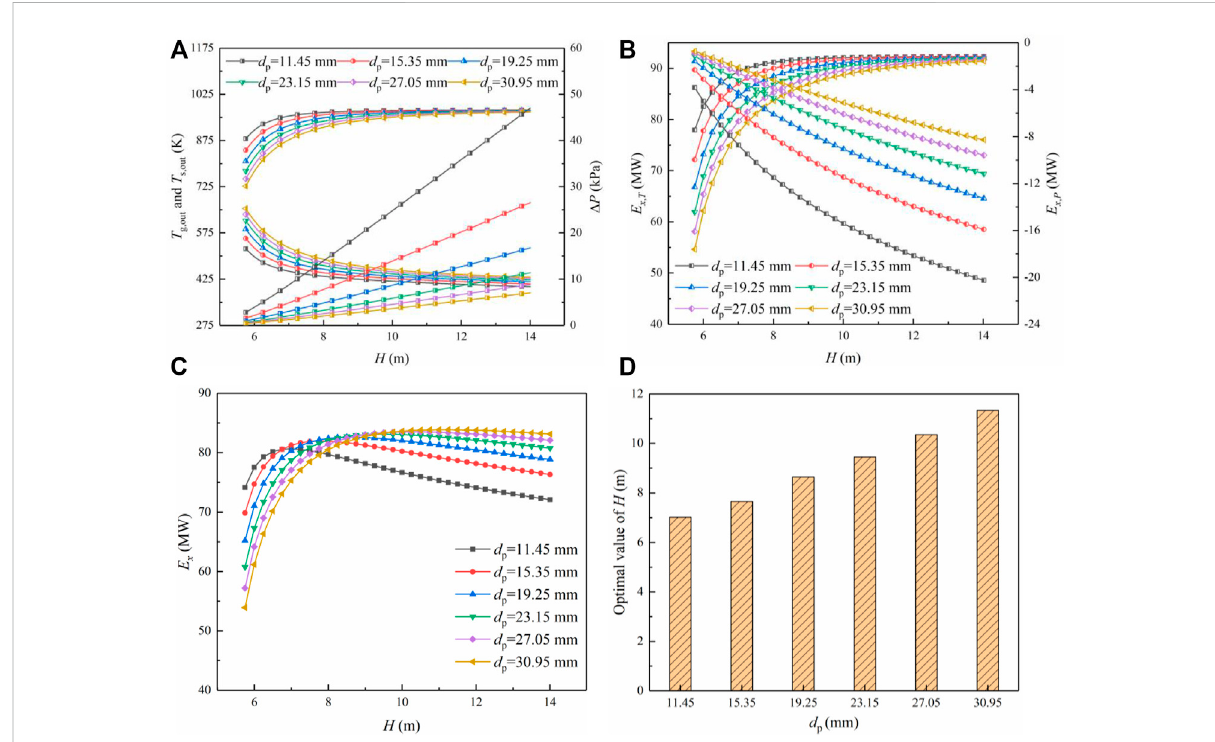
FIGURE 14 Thein fl uenceoftheheight ofthesinterlayer H onthevertical cooling process underdifferentmulti-sizesinters: (A) Changeofthesinter outlet temperature T s , out , gas outlet temperature T g , out and pressure drop Δ P with H ; (B) Change of the temperature exergy E x , T , and pressure exergy E x , P with H ; (C) Change of the income exergy E x with H ; (D) Change of the optimal value of H with the equivalent particle diameter d p